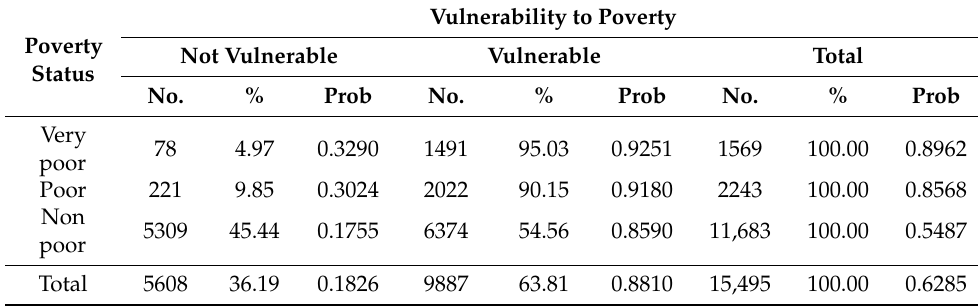
Table 6. Vulnerability with Social Expenditure,